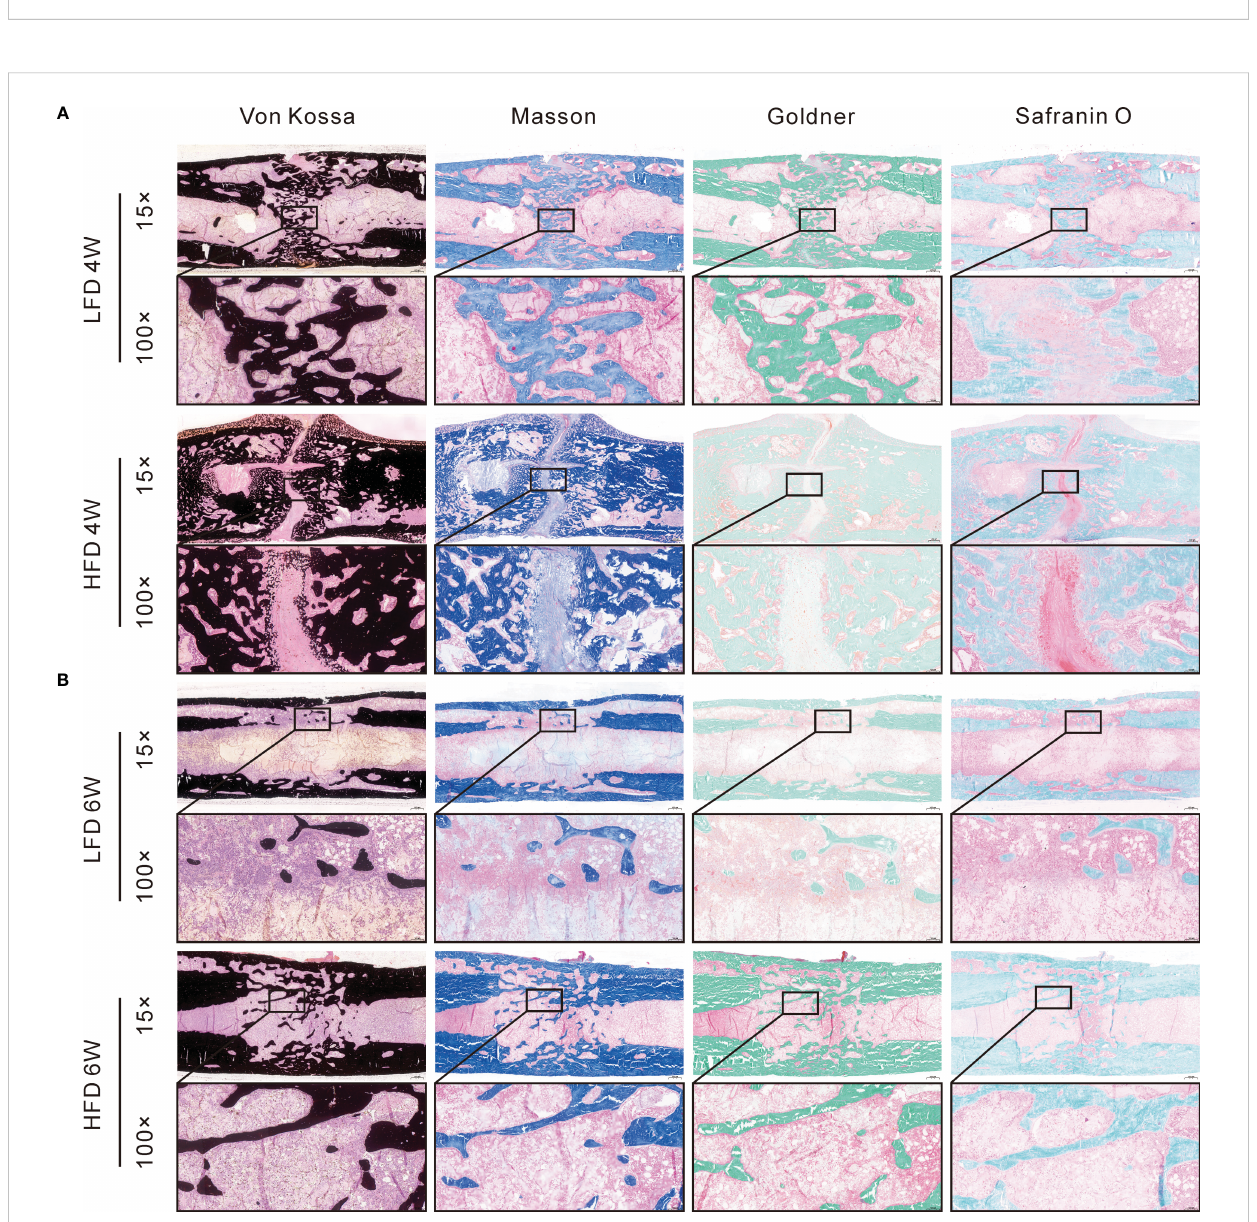
FIGURE 6 Histomorphological analysis of bone regeneration during the consolidation period. Von Kossa, Masson, Goldner Trichrome, and Safranin O & Fast Green staining indicated the decreased bone regeneration in HFD group. (A) 4-weeks consolidation. (B) 6-weeks